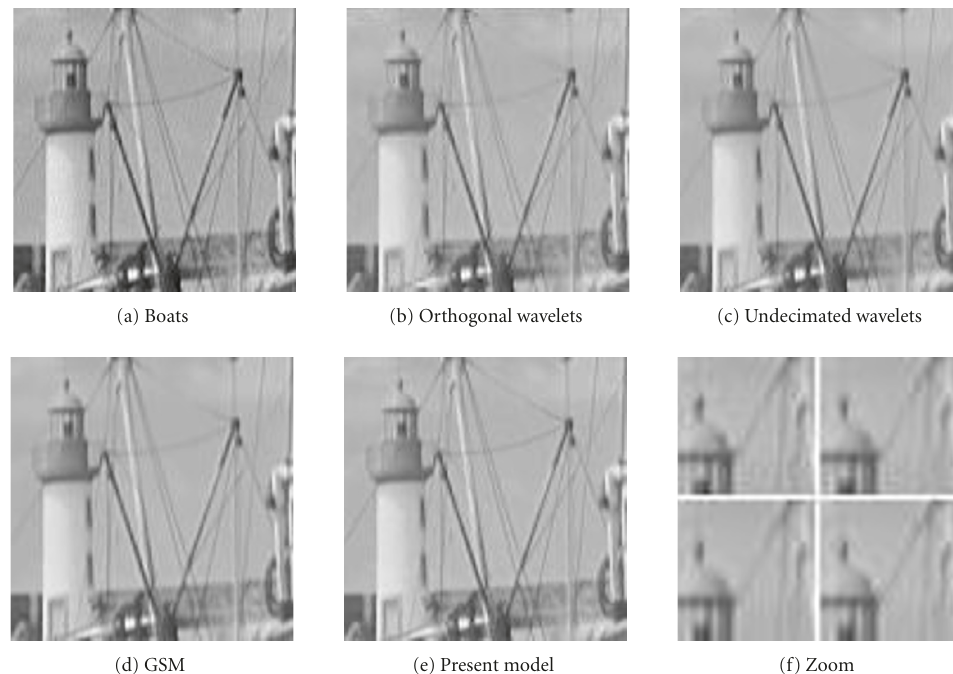
Figure 12: Denoising results at low noise level. (a) The original image “Boats” (120 × 120 pixels) already contains a low level of noise. The image is denoised using (b) orthogonal wavelet, (c) undecimated wavelet, (d) the GSM model and (e) the present model. The proposed method preserves particularly long lines and edges, as, for example, the wires at the top and at the left of the image. Di ff erent details appear smoothed by the other methods while they remain sharp for the proposed method. (f) 30 × 30 zoom for original, undecimated, GSM, and the present model (left to right and top to